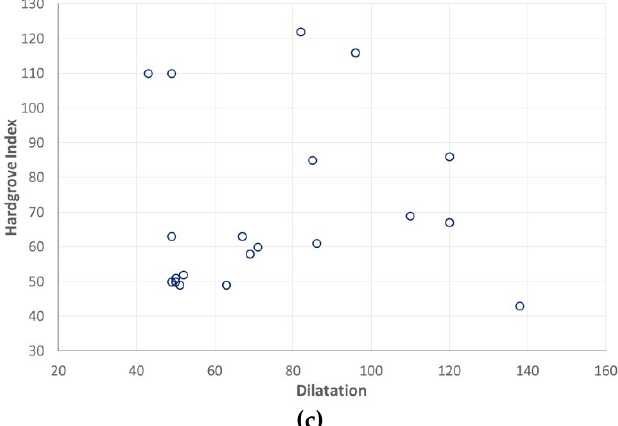
Figure 6. The value of Hardgrove index as a function of coking parameters of the coals studied: ( a ) Roga index, ( b ) free swelling index and ( c ) dilation.